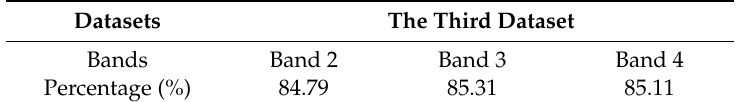
Table 6. The percentages of the squared error ( (cid:2026) (cid:3017)(cid:2870) ) that is lower than the estimation variance ( (cid:2026) (cid:3006)(cid:2870) ) for the third dataset.